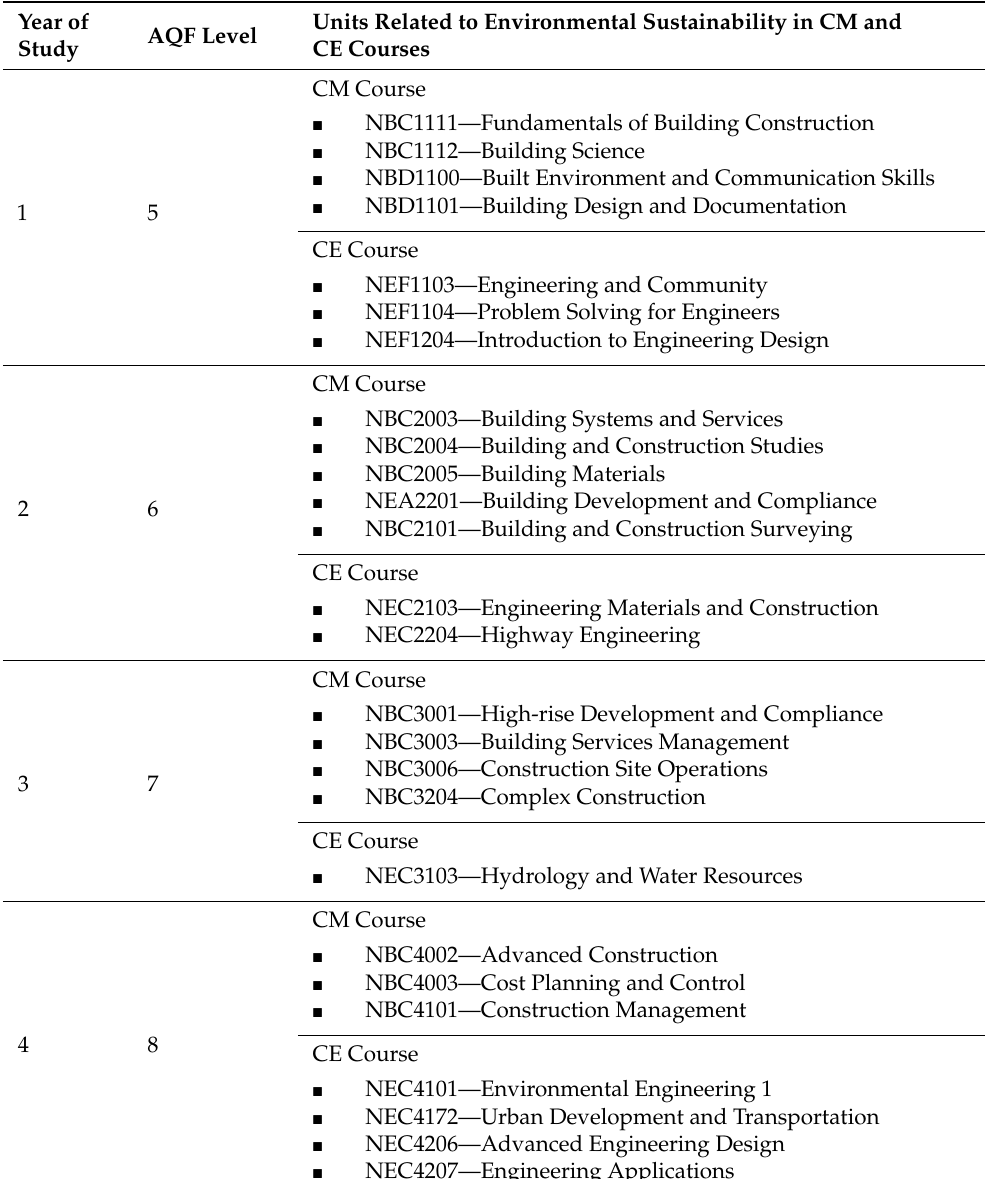
Table 3. Victoria University’s CM and CE programs: qualifications and subjects in each year of